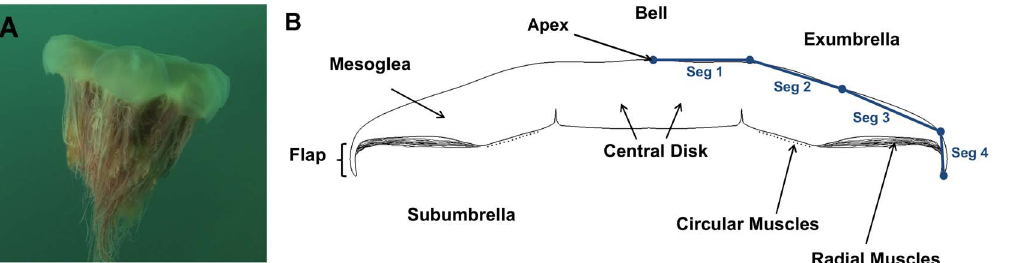
Fig. 1. Cyanea Capillata. (A), image of a Cyanea capillata in the relaxed position. (B), Schematic of a C. capillata bell cross-section showing different anatomical parts and a four-segment model of the exumbrella.